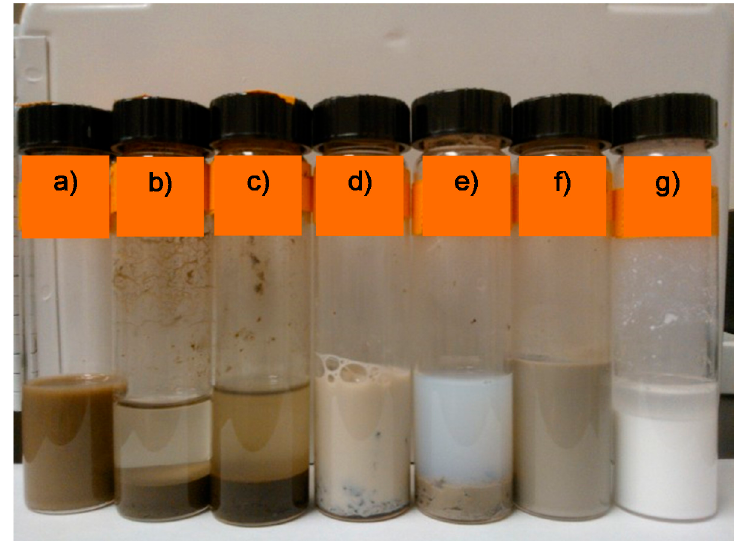
Figure 9. Stability of miniemulsion latex after sitting for more than 3 months. ( a ) 0.5% GO, 10% PVA, ( b ) 1% GO, 10% PVA, ( c ) 2% GO, 10% PVA, ( d ) 0.5% GO, 0% PVA, ( e ) 0.5% GO, 5% PVA, ( f ) 0.5% GO, 20% PVA, ( g ) 0% GO, 10% PVA.